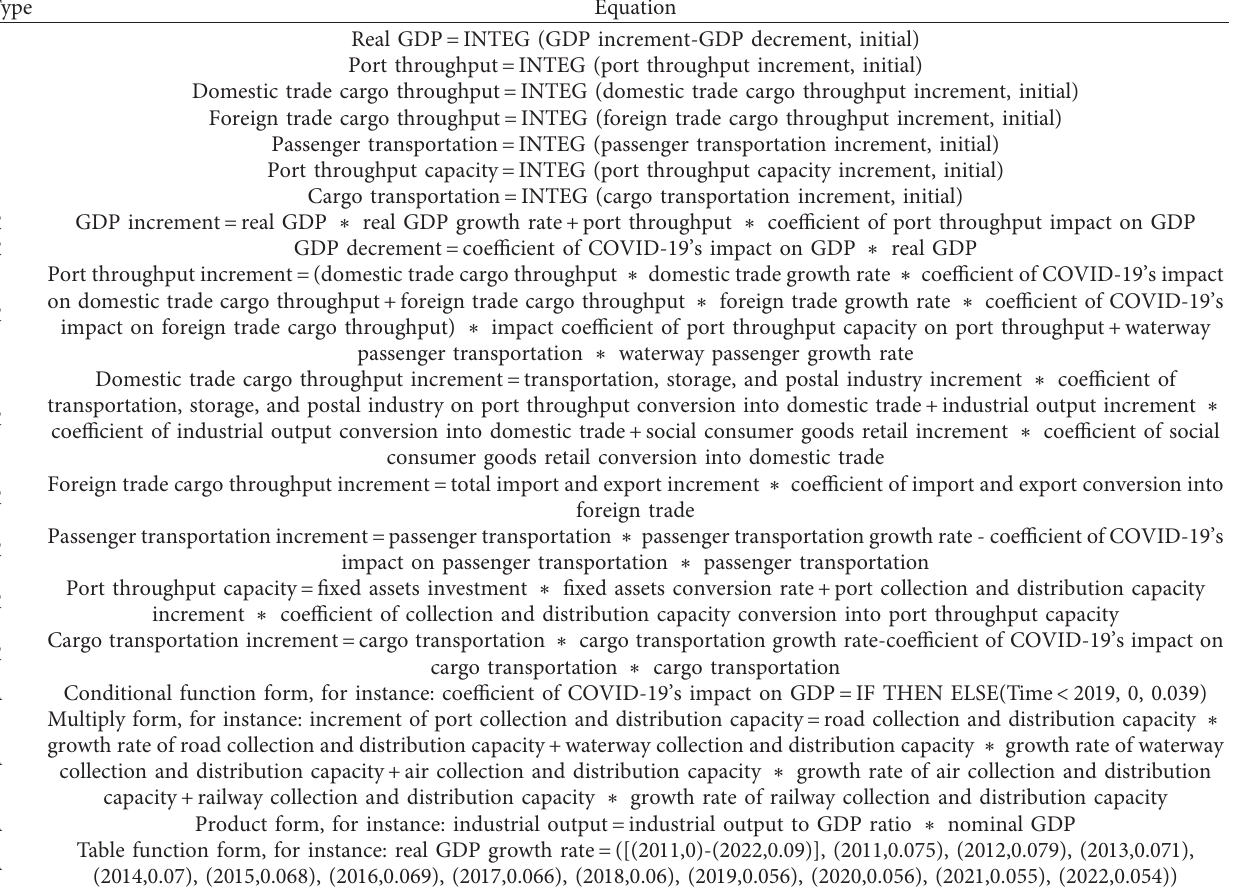
Table 2: Equations in the model.